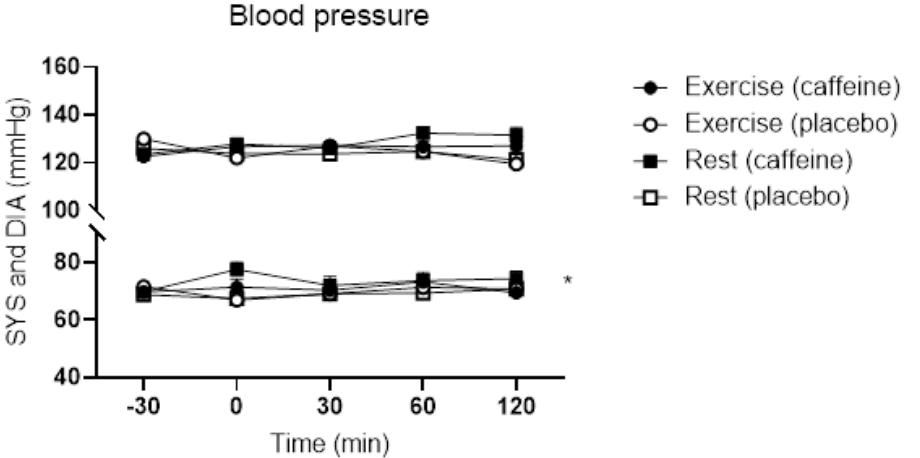
Figure 4. Blood pressure during the OGTT with and without caffeine intake before. OGTTs were conducted with and without an acute bout of exercise the evening before. Abbreviations: SYS: systolic blood pressure; DIA: Diastolic blood pressure. Data are mean ± SEM. *: p < 0.05; Two-way ANOVA comparing diastolic blood pressure with and without caffeine.